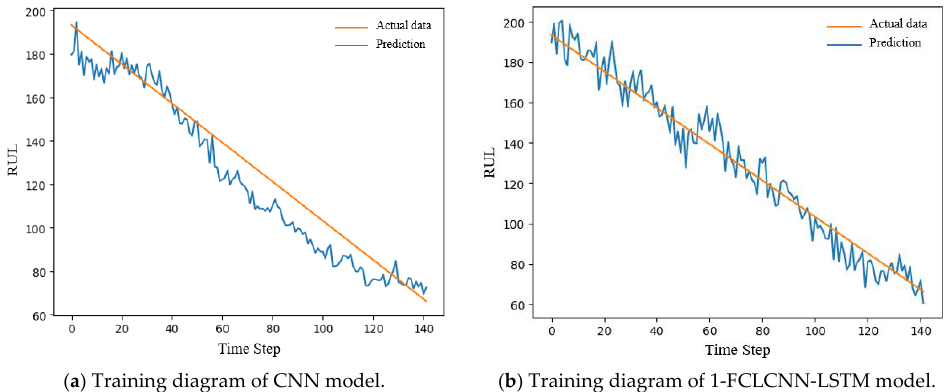
Figure 13. Training diagram of the same FD003 engine under two models. Table 5. RMSE training values of FD001 and FD003 under the two models.